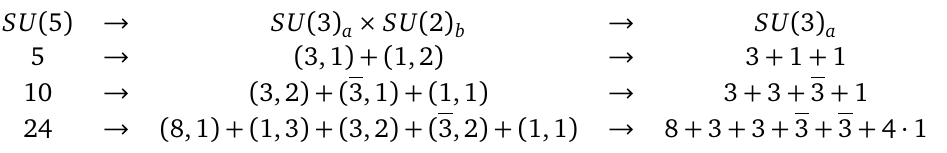
× SU ( 2 ) and SU ( 3 ) into represen- a b a